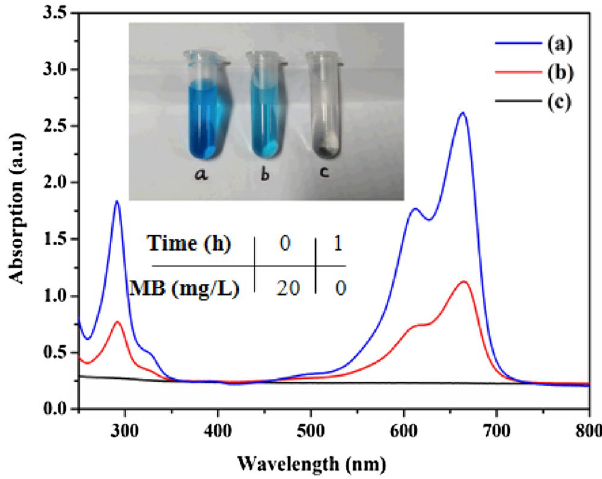
Figure 8. The UV–Visible spectra of methylene blue (MB) before and after photocatalytic degradation by Ag@ AgCl-reinforced cellulose composites for ( a ) 0, ( b ) 0.5, and 1 h. The up inset is the picture of MB solution before and after photocatalytic degradation by Ag@AgCl-reinforced cellulose composites. The down inset is the MB concentrations with different photocatalytic